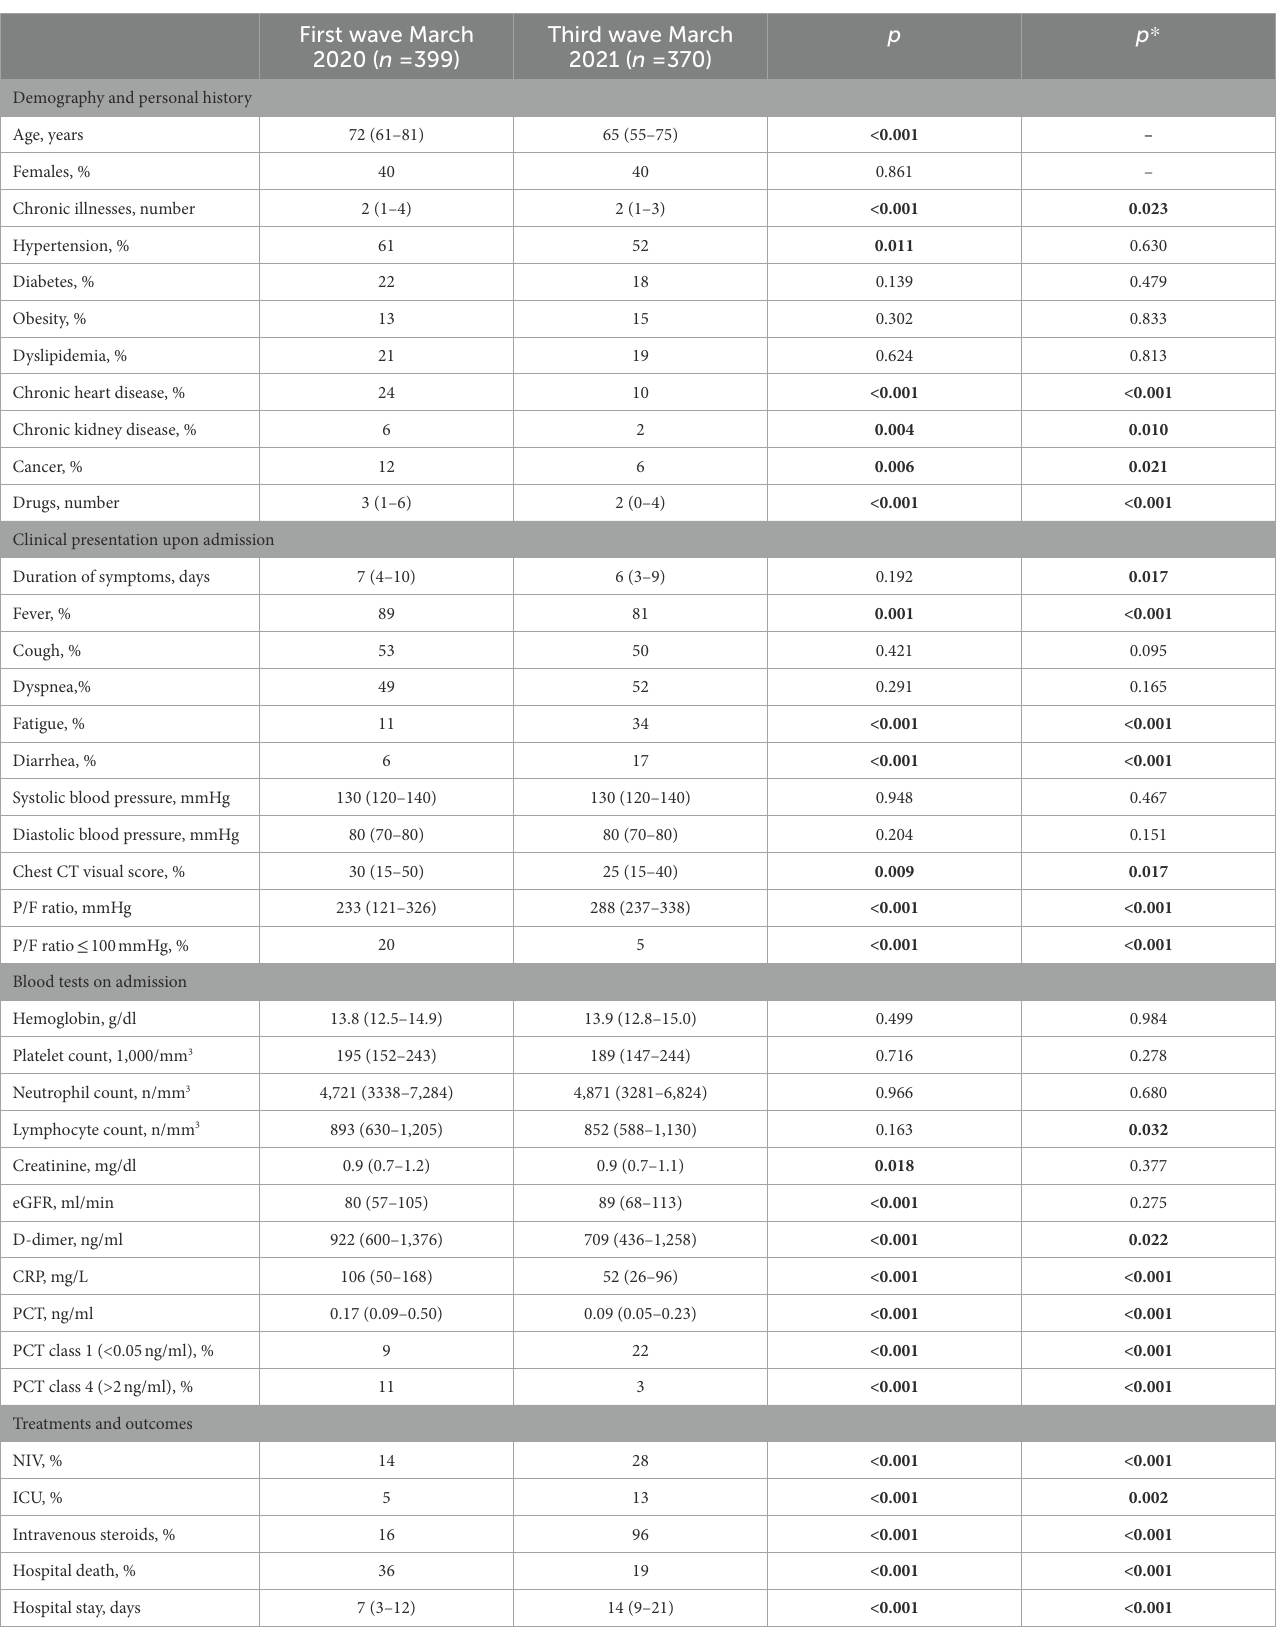
TABLE 1 Comparison of the main characteristics of COVID-19 presentation and outcomes between patients admitted during the first wave (March 2020, n = 399) and the third wave (March 2021, n =